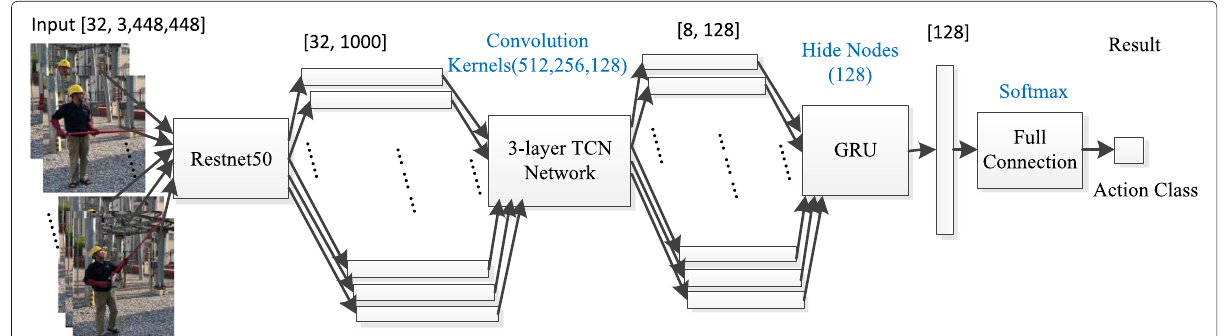
Fig. 6 The structure and parameter settings of the action recognition